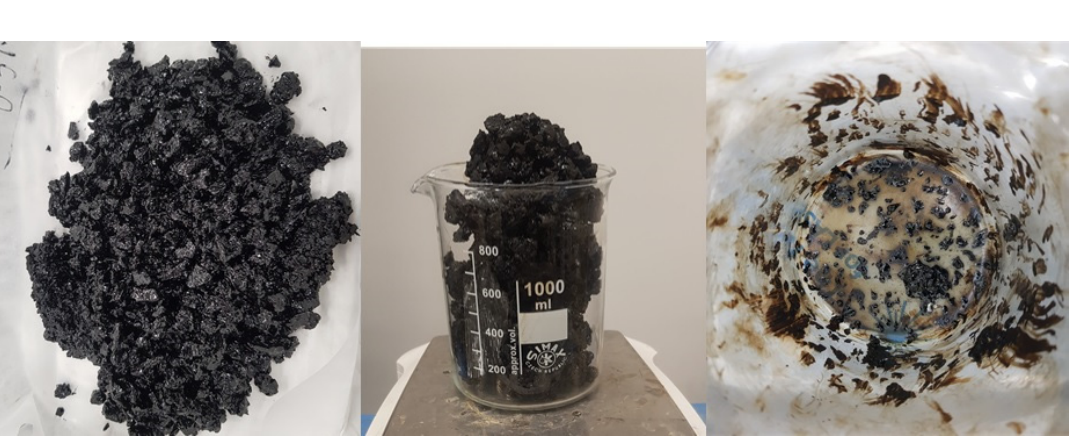
Table 8. Binder drain off test results.